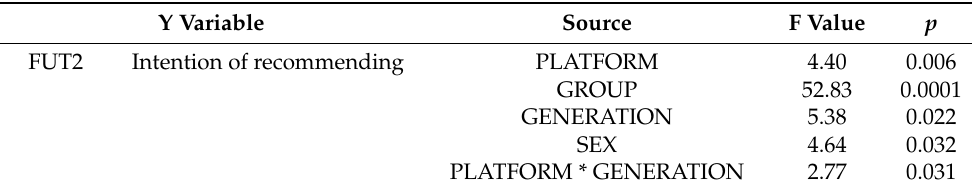
Table 7. Model with FUT2 “Intention of recommending the